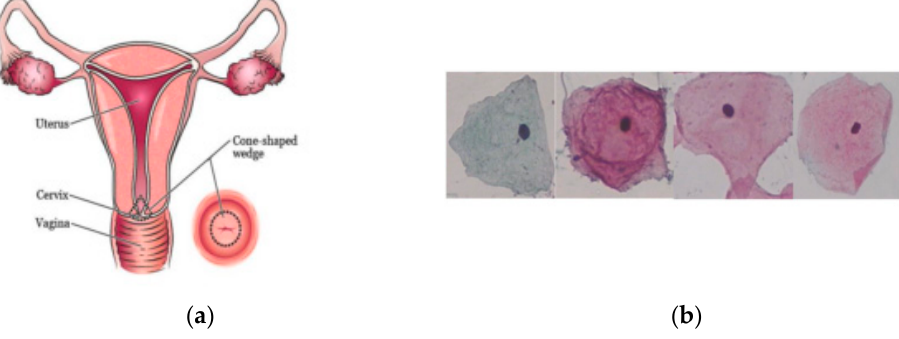
Figure 1. ( a ) Autonomy of women’s cervix. ( b ) Cervical cell cytology images of Herlev dataset [36]. Cervical